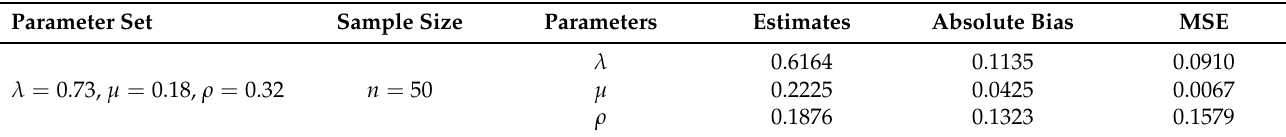
Table 2. The MLE simulation results for the three parameters λ , µ , and ρ . Parameter Set Sample Size Parameters Estimates Absolute Bias MSE λ = 0.73, µ = 0.18, ρ = 0.32 n =